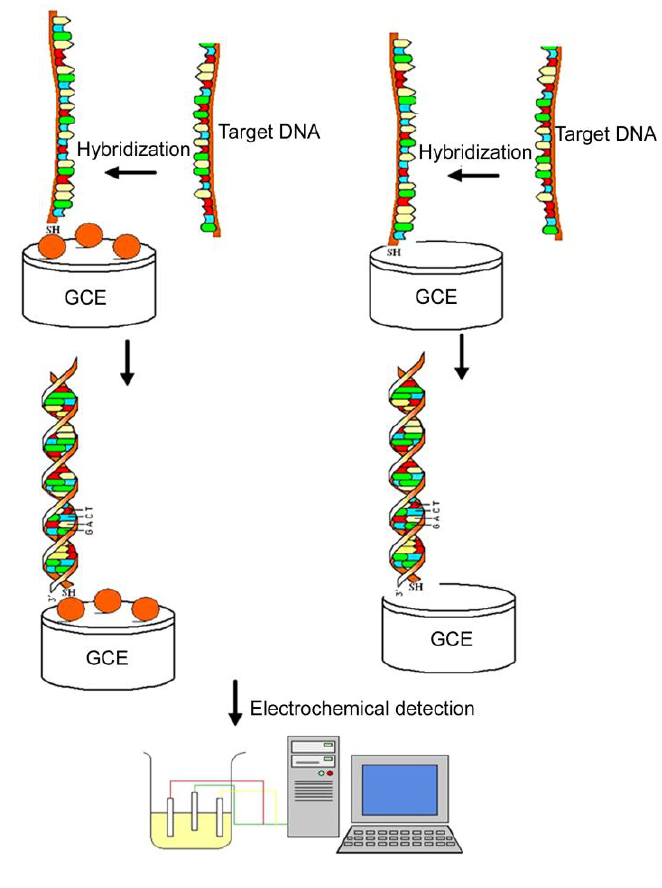
Figure 3. Process of CdS-modified GCE for the detection of DNA hybridization. (Left) Formation of a layer of CdS-ODN nanoconjugates on the surface of GCE before DNA hybridization. (Right) Direct mobilization of ODN on the surface of bare GCE for DNA hybridization detection. Reprinted with permission from [46]. Copyright